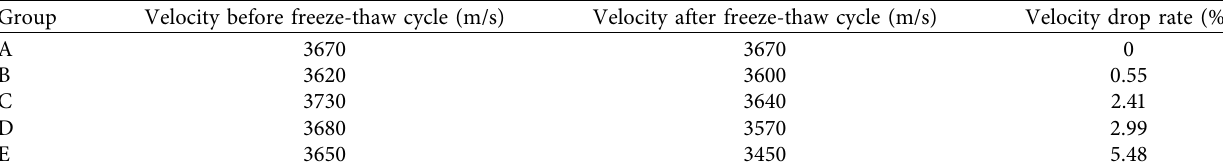
Table 3: P-wave velocity of the different groups before and after freeze-thaw cycling. Group